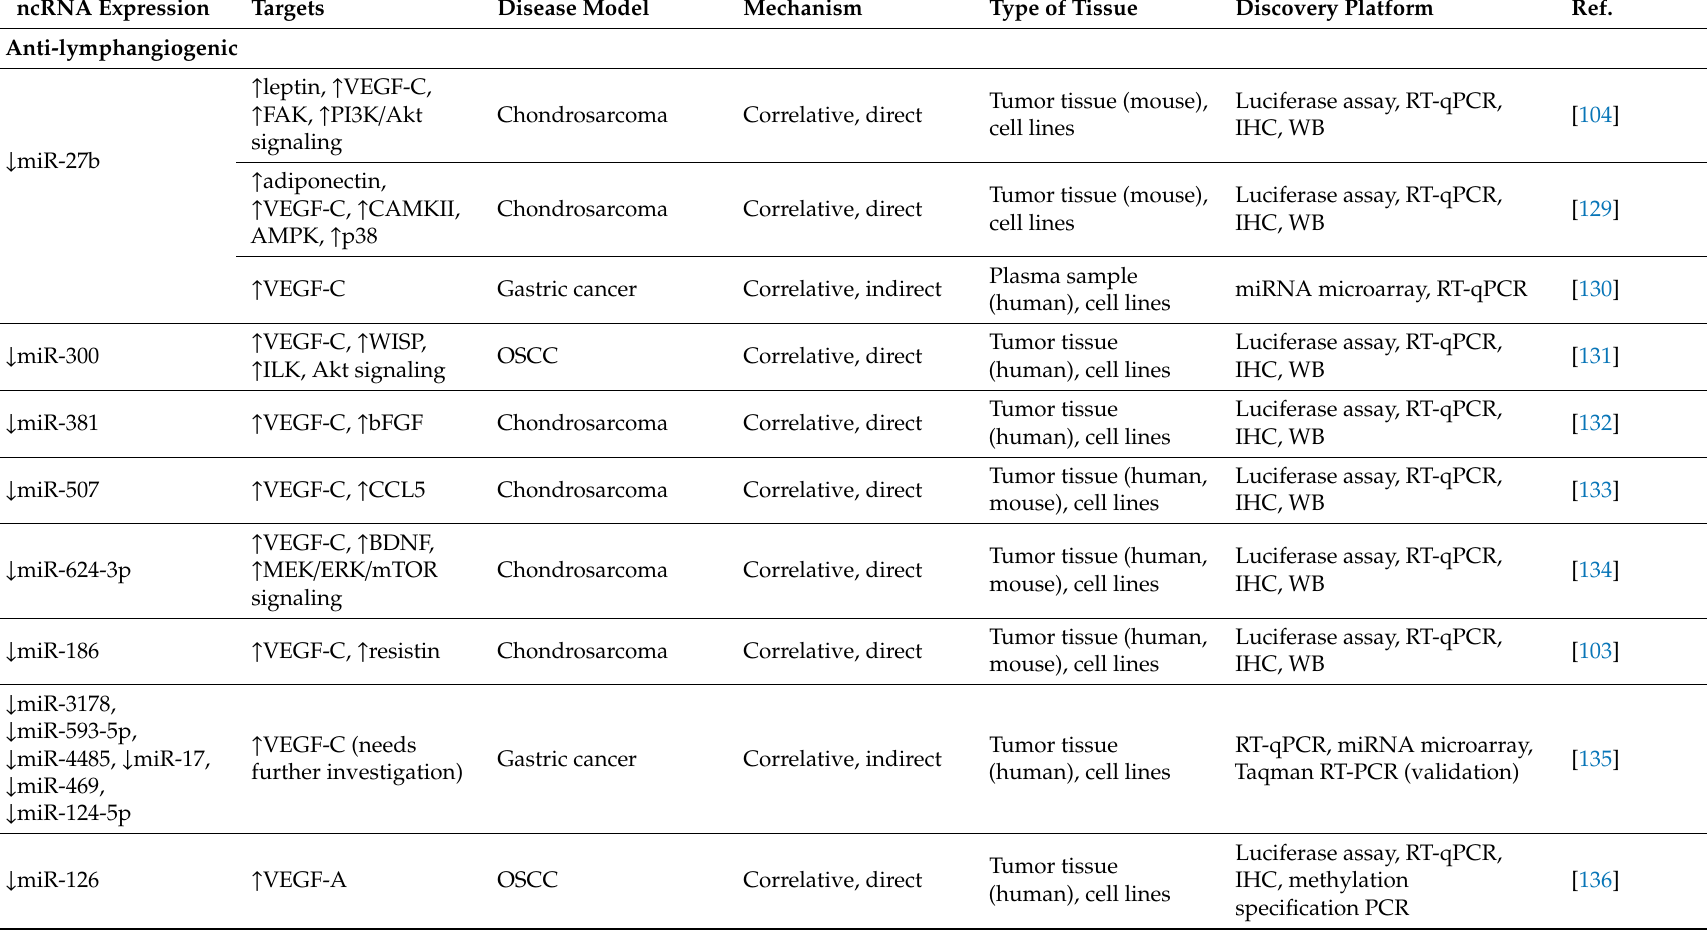
Table 1. Summary of ncRNAs that mediate lymphangiogenesis and their targets in di ff erent tumor microenvironments, with the specific mechanisms, types of tissues, and discovery platforms applied in reported